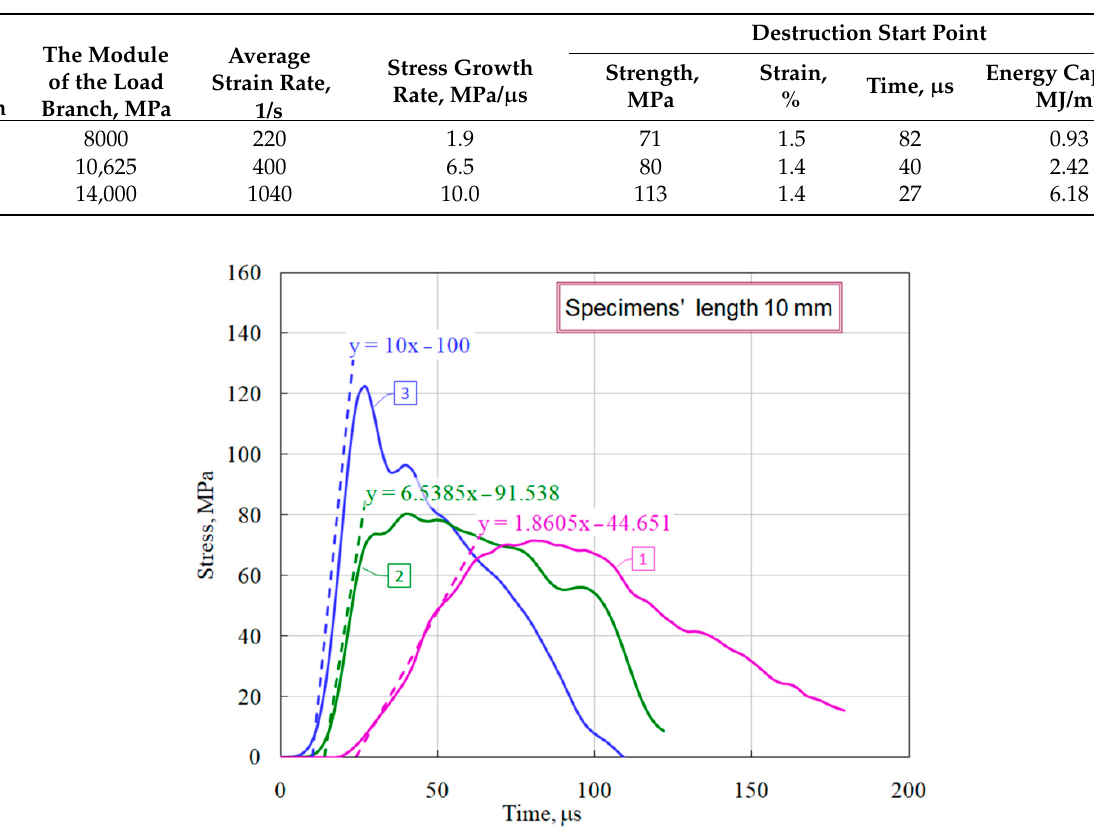
Figure 7. Definition of modules of load branches. Table 2. Results of dynamic tests of ceramics.